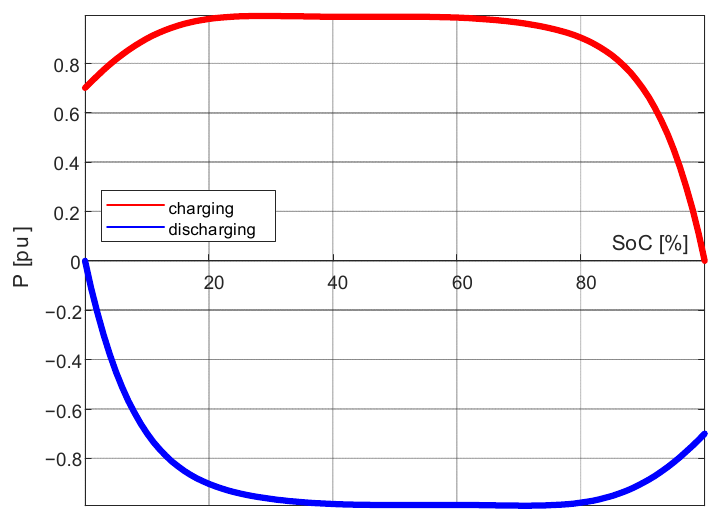
Figure 1. Dependence of the storage unit power on the state of charge (SoC).